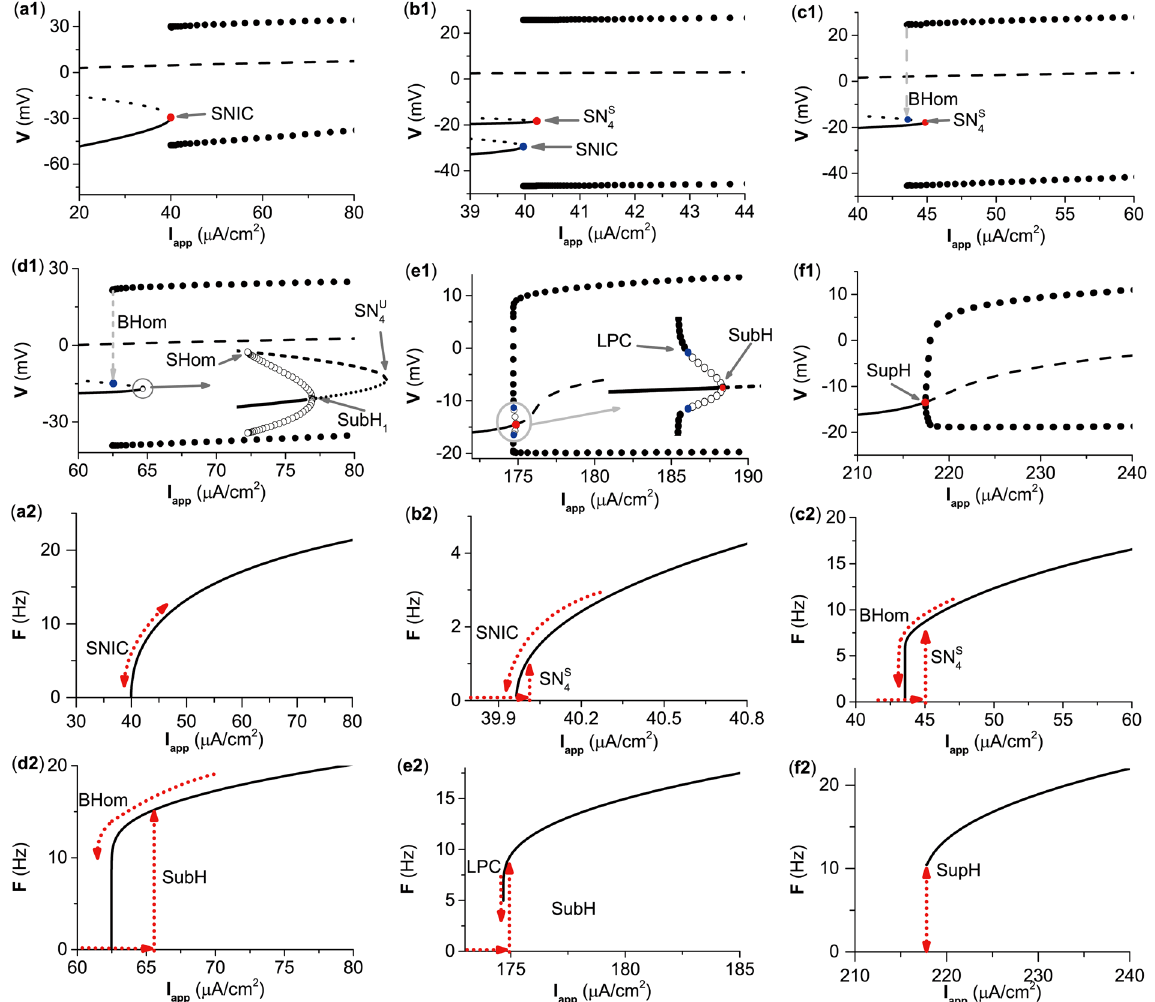
Figure 2. Dynamics of the ML model with respect to I app at different g exc values. ( a1 – f1 ) Bifurcation diagrams showing voltage at equilibriums and at max/min of limit cycle as I app is increased when g inh at different values. ( a2 – f2 ) Frequency-current (F-I) curves showing firing frequency as I app is increased when g inh at different values. ( a1 , a2 ) g inh = 0 μ S/cm 2 . ( b1 , b2 ) g inh = 0.372 μ S/cm 2 . ( c1 , c2 ) g inh = 0.5 μ S/cm 2 . ( d1 , d2 ) g inh = 1.0 μ S/cm 2 . ( e1 , e2 ) g inh = 3.5 μ S/cm 2 . ( f1 , f2 ) g inh = 4.4 μ S/cm 2 . In panels (a1–f1), the solid, dotted and dashed lines represent stable equilibrium, saddle and unstable equilibrium, respectively. The upper and lower solid (open) circles are the maximum and minimum values of the stable (unstable) limit cycle, respectively. SNIC represents saddle- node bifurcation on an invariant circle. SubH and SupH represent subcritical Hopf bifurcation and supercritical Hopf bifurcation, respectively. BHom and SHom represent saddle homoclinic orbit bifurcation. SN 4S and SN 4U represent saddle node bifurcation of equilibrium. LPC represents saddle node bifurcation of limit